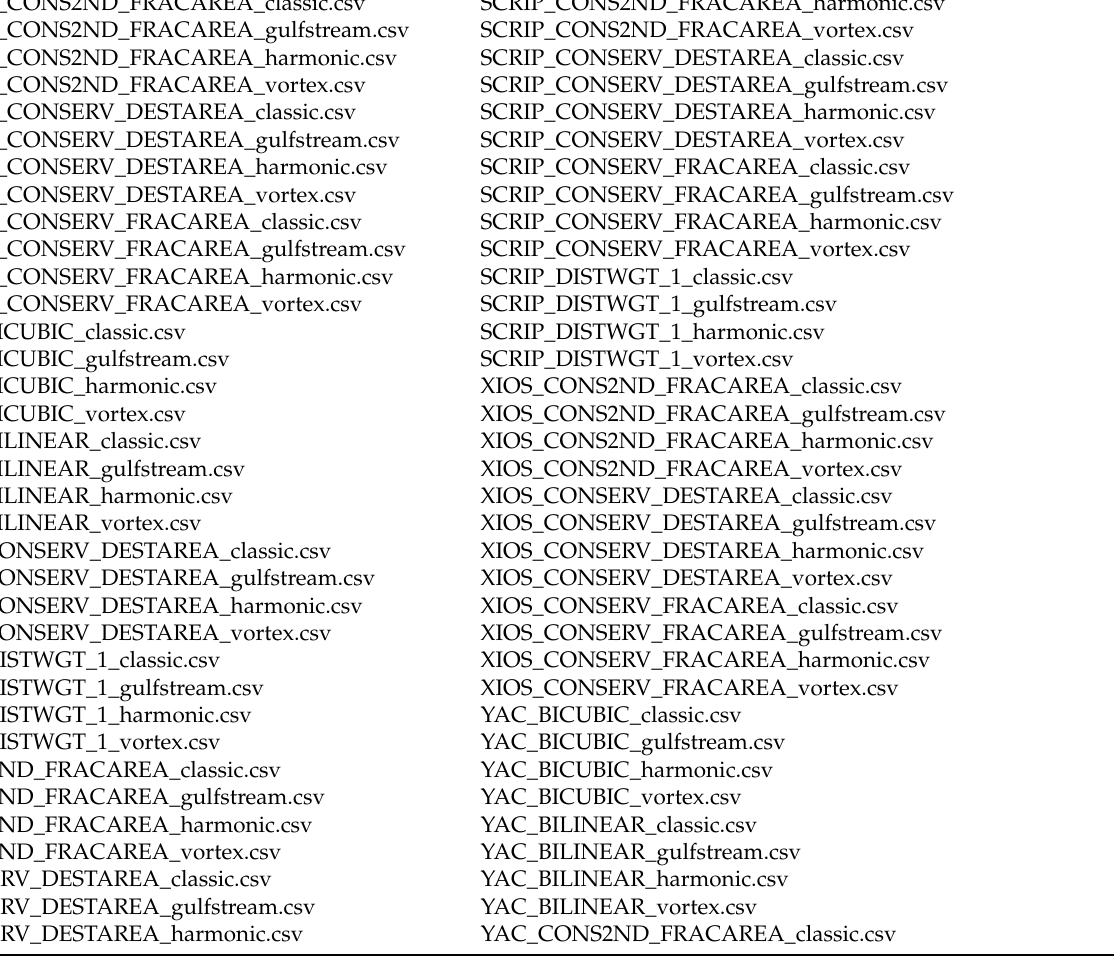
Table A1. Regridding benchmark files included in the tar file Regridding_Benchmark_metrics.tar available on Zenodo at https://doi.org/10.5281/zenodo.5343166 (accessed on 31 August 2021). ESMF-820bs08-U_CONS2ND_FRACAREA_classic.csv